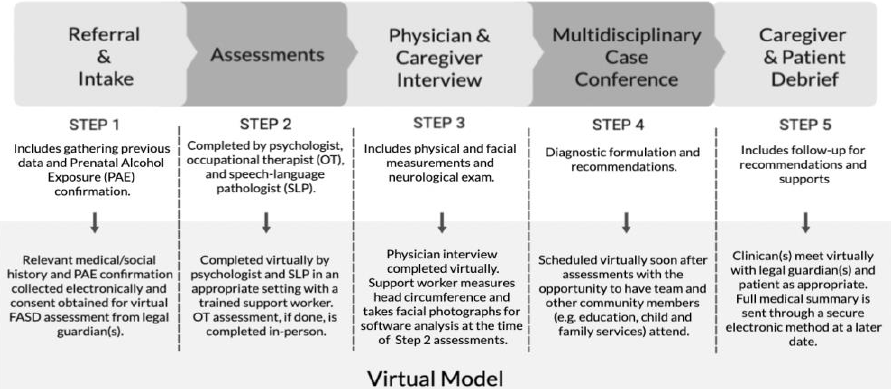
Figure 1. The in-person and virtual diagnosis and assessment model of Fetal Alcohol Spectrum Disorder in children.